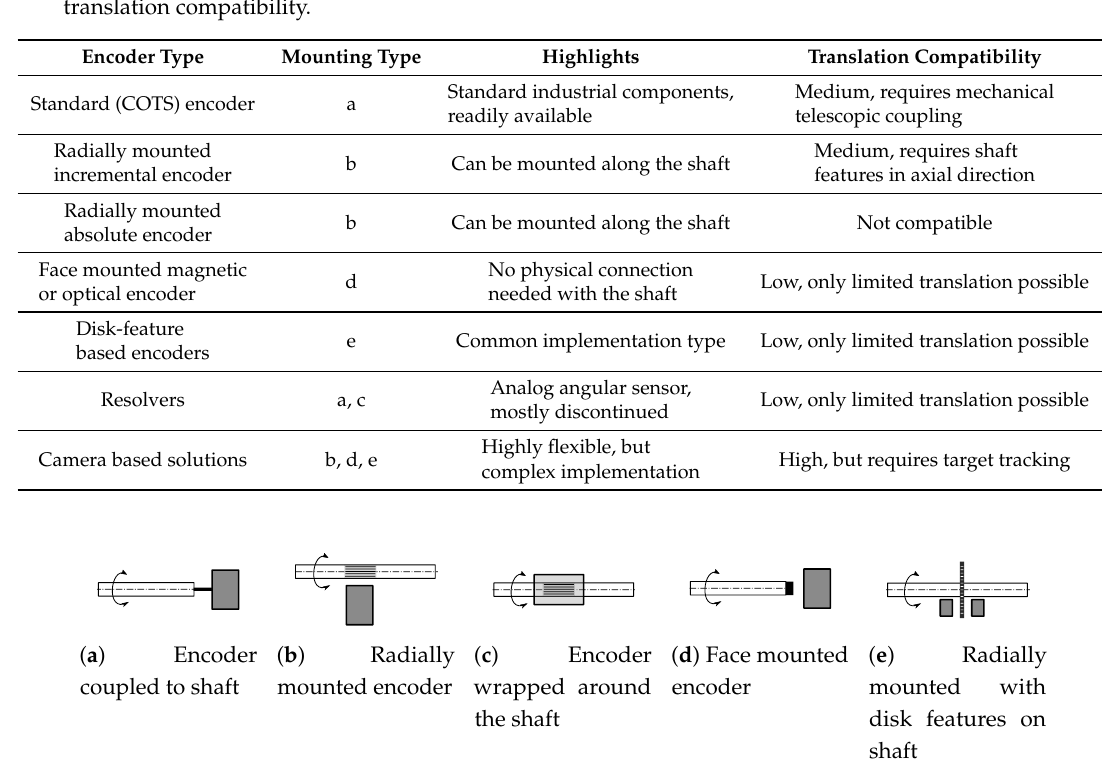
Figure 1. Common encoder mounting